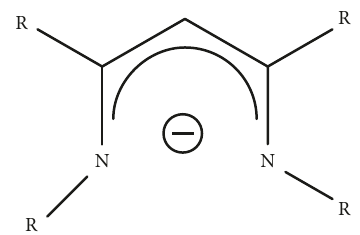
Scheme 1: Schematic diagram of “nacnac”.